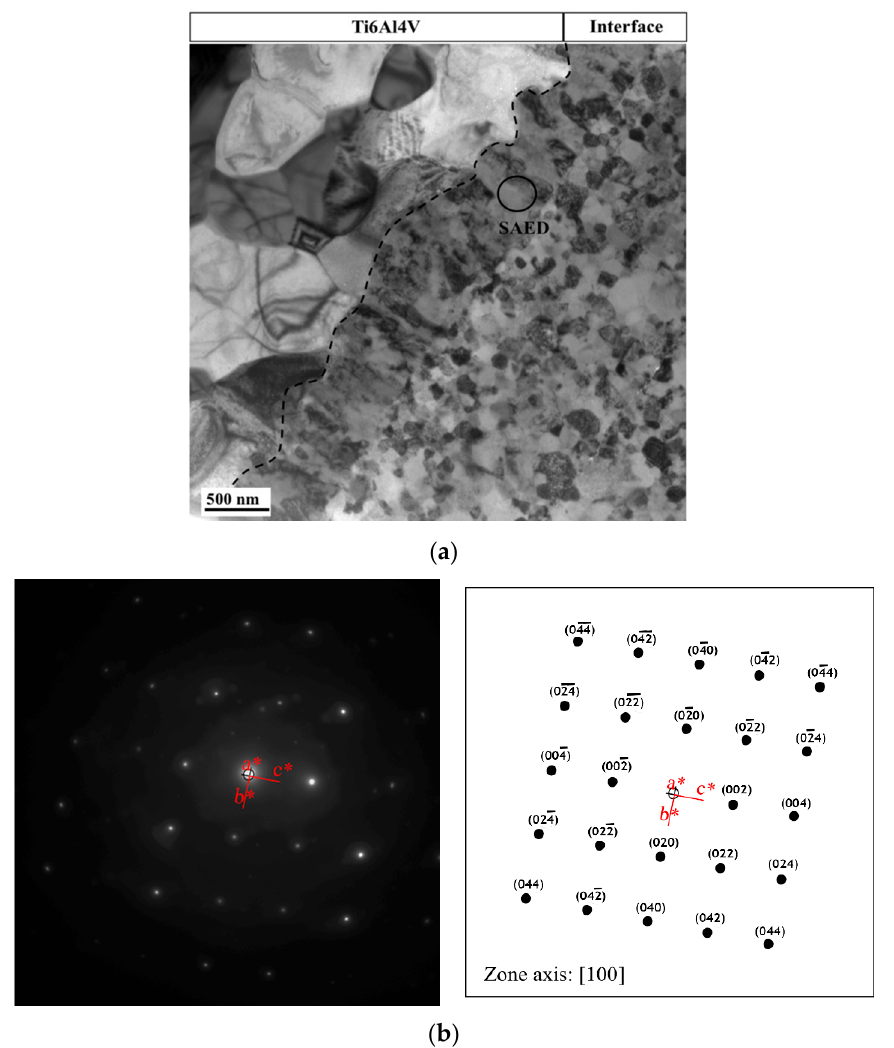
Figure 7. ( a ) TEM image of the TiNi/Ti6Al4V joint and ( b ) SAED of the selected area indicated in ( a ) and the indexing scheme of the AlNi 2 Ti phase.